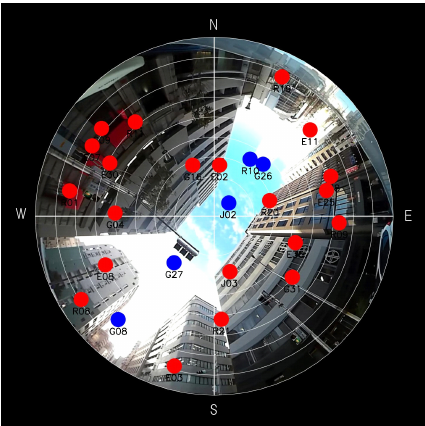
Figure 1. A sky plot onto a fisheye-camera image taken at Kobe city, Japan. A blue dot represents a LOS satellite and a red dot represents a NLOS satellite. N, S, E, and W stand for North, South, East, and West,